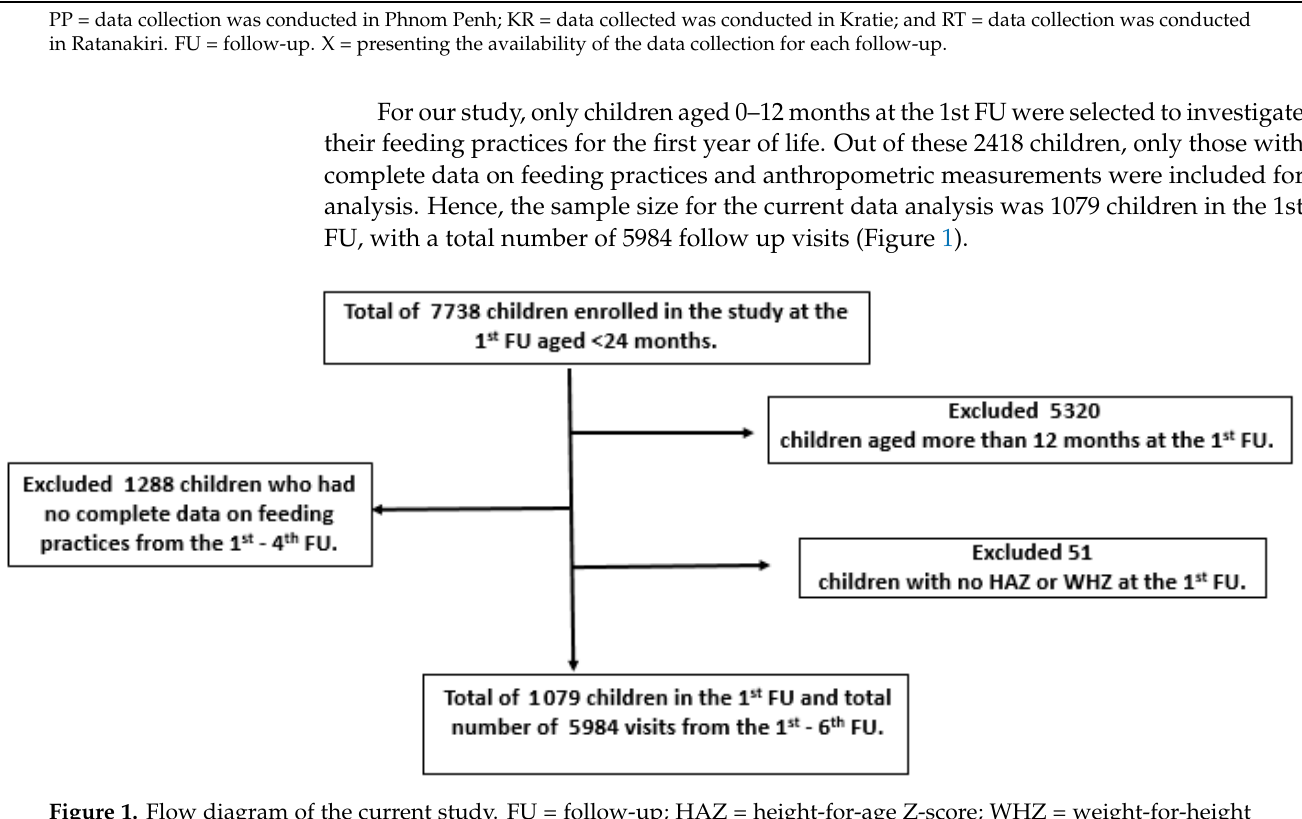
Figure 1. Flow diagram of the current study. FU = follow-up; HAZ = height-for-age Z-score; WHZ = weight-for-height Z-score.